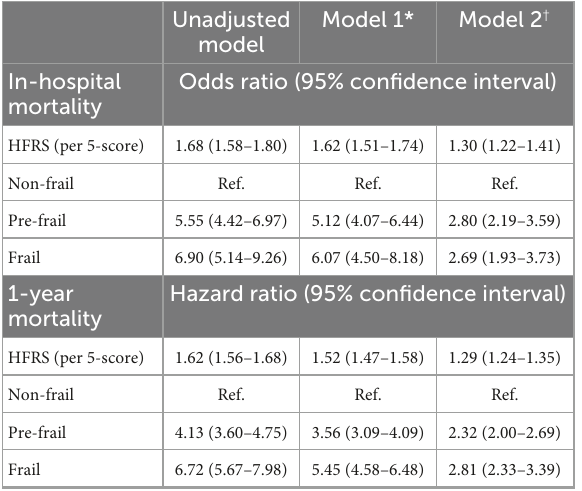
TABLE 4 Subgroup analyses of the associations between frailty and in-hospital and 1-year